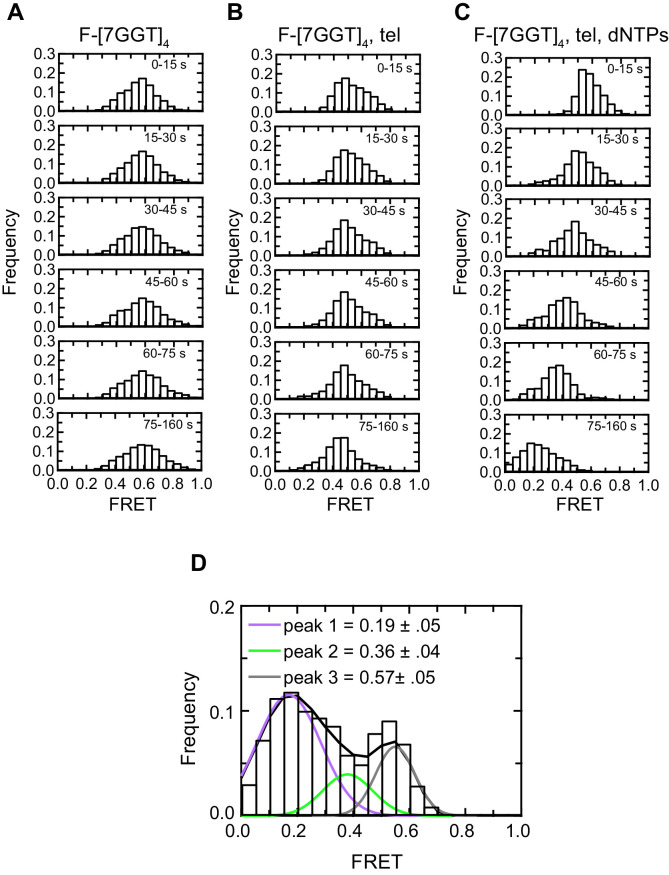
Histogram representations of F-[7GGT]4 data.(A–C) Histograms showing changes in FRET values of a population of molecules under different experimental conditions over 160 s, binned into 15–85 s time intervals. (D) Histogram showing three different FRET populations in the presence of telomerase and dNTPs; a multiple Gaussian fit was applied to obtain the mean FRET peaks of these populations, with errors representing the curve fitting errorstandard deviation of the data. n = 105 (A), 87 (B) and 81 (C), (D) molecules, collected in 4–6 independent experiments.